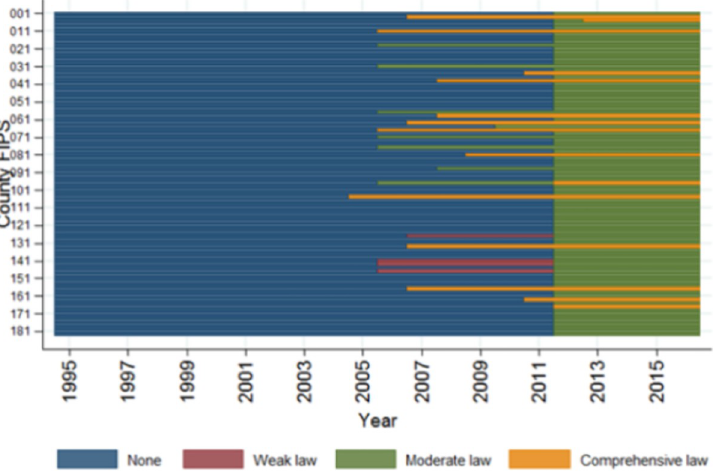
Fig 1. Transitions of Indiana municipal smoke-free ordinances, 1995–2016. FIPS = federal information processing standard code which identifies counties.